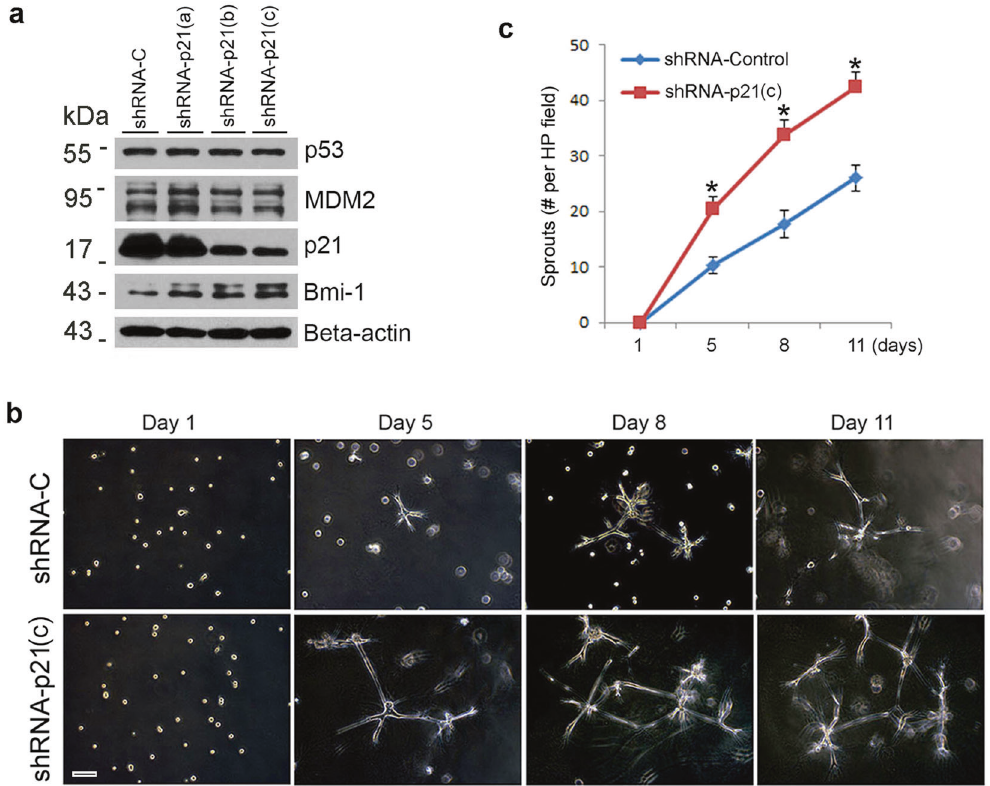
Fig. 4 p21 is a downstream effector of p53-mediated regulation of the vasculogenic fate of dental pulp stem cells. a DPSC were transduced with shRNA scramble and shRNA-p21, western blot was performed for p53, MDM2, and Bmi-1. b , c shRNA scramble and shRNA- p21 transduced DPSC were seeded in growth factor-reduced matrigel and cultured in endothelial differentiation medium for different time points. b photographs of sprouts, scale bar:100 µm. c Graph depicting the number of sprouts formed in b . Asterisk indicates p < 0.001, as determined by one-way ANOVA followed by a post hoc test (Tukey ’ s